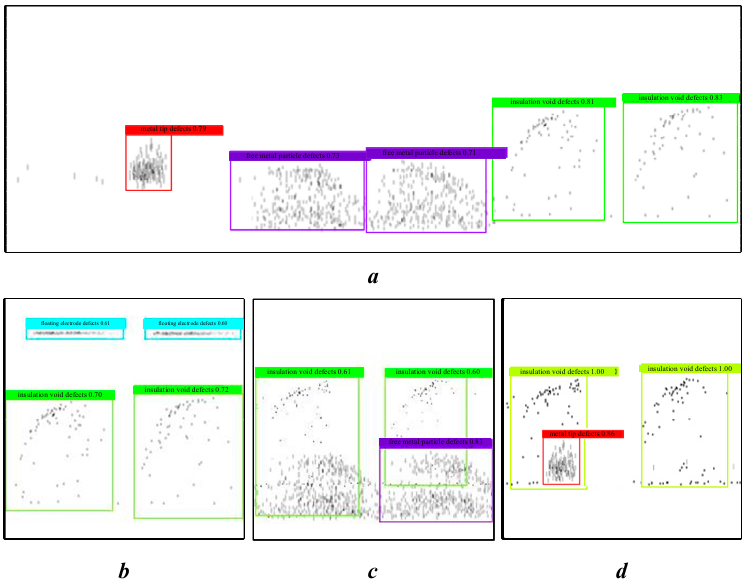
Figure 12. Multi-defect detection results. ( a ) metal tip defects, free metal particle defects and insulating void defects, ( b ) floating electrode defects and insulating void defects, ( c ) insulating void defects and free metal particle defects, ( d ) metal tip defects and insulating void defects.